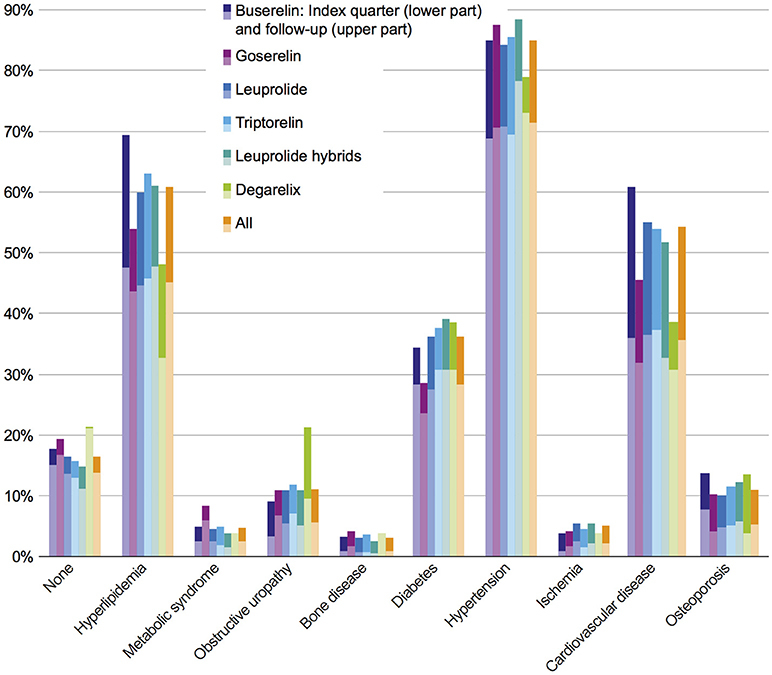
Prevalence of comorbidities in index quarter and follow-up period in all investigated cohorts. Each bar indicates prevalence of comorbidities in index period (lower part) + 3 year follow-up (upper part).